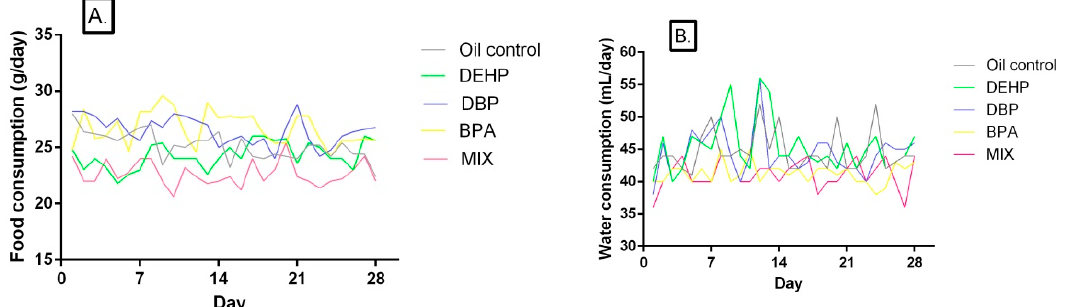
Figure 1. ( A ) Food (g / day) and ( B ) water (mL / day) consumption of rats exposed to DEHP, DBP, BPA, and their mixture each day for 28 days.